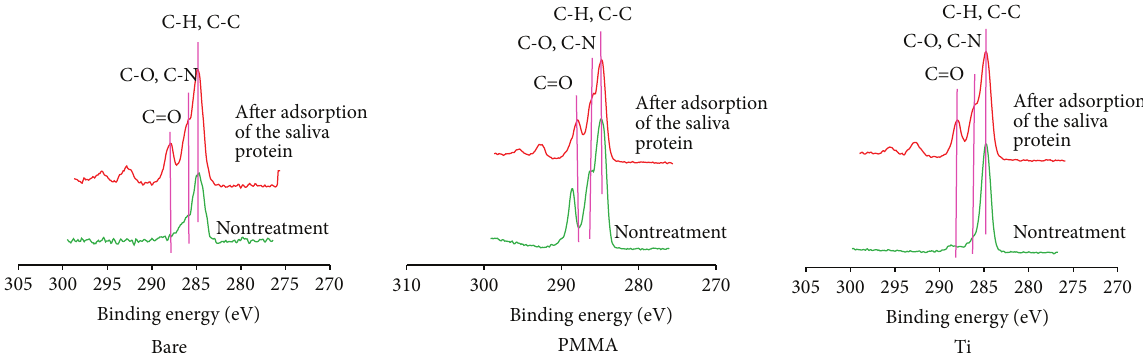
Figure 8: XPS analysis after adsorption of BSA. C1s XPS spectra for BSA adsorbed onto bare, PMMA, and Ti QCM sensors. C1s XPS spectra before (green) and after (red) adsorption for BSA.